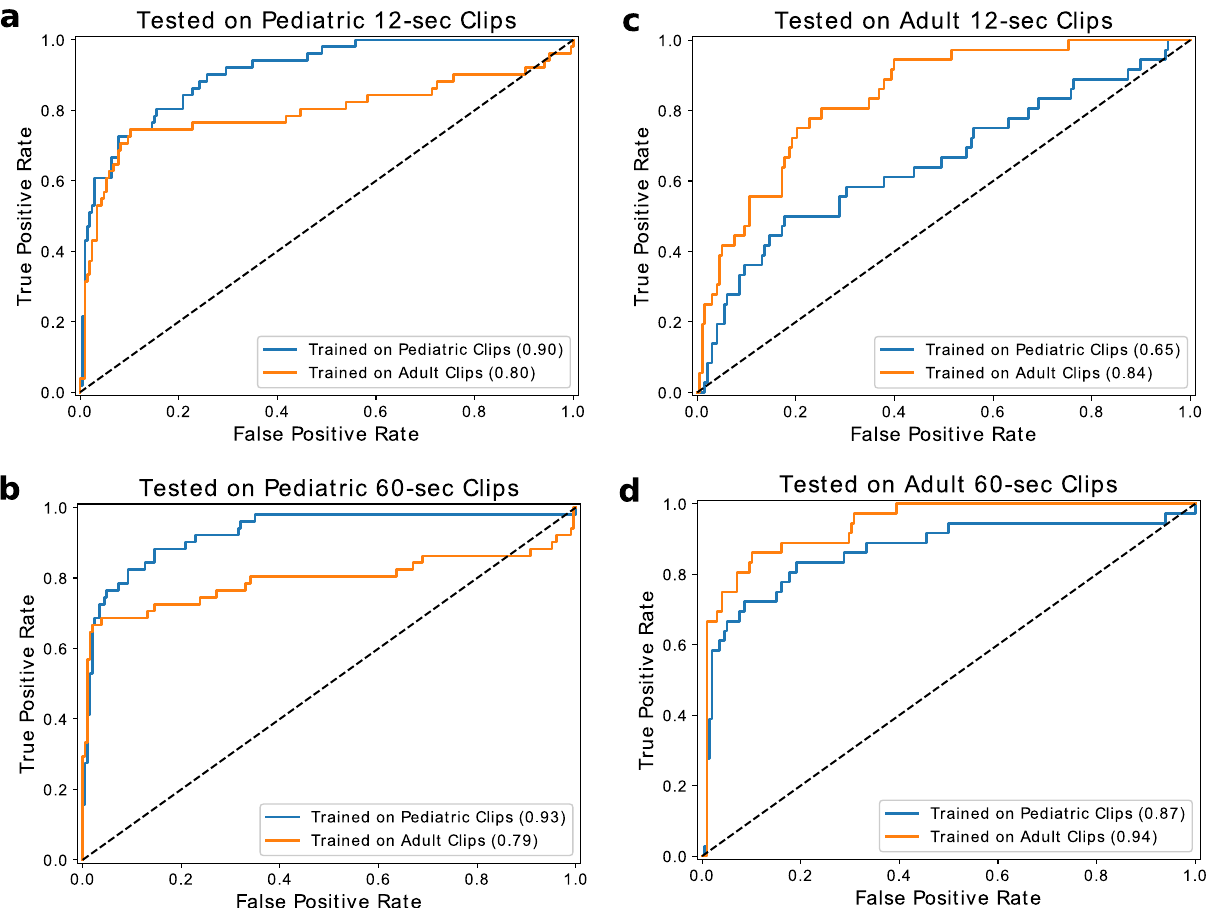
Fig. 4 Generalization performance across pediatric and adult populations. We demonstrate the difference in performance when the model is trained on the two datasets and tested on the pediatric clips ( a , b ), and the adult clips ( c , d ). The orange lines indicate models trained on the pediatric population, while the blue lines indicate models trained on the adult